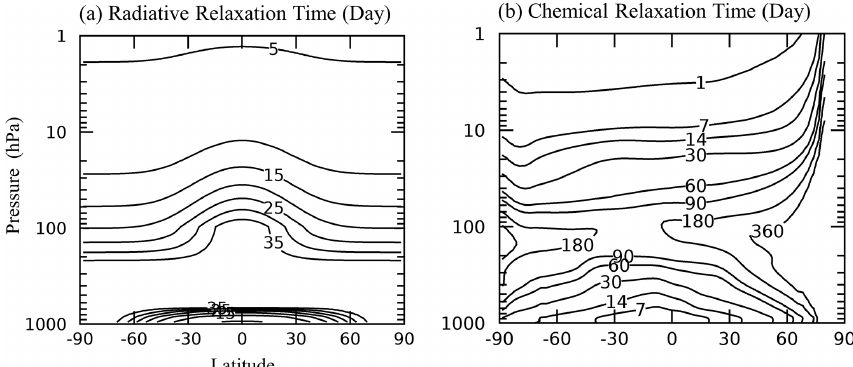
Figure 1. Latitude–height cross-sections of relaxation times (days). Panel (a) is the temperature (Newtonian) relaxation time τ , and panel (b) is the chemical relaxation time for ozone ( − 1 /c 1 ) in